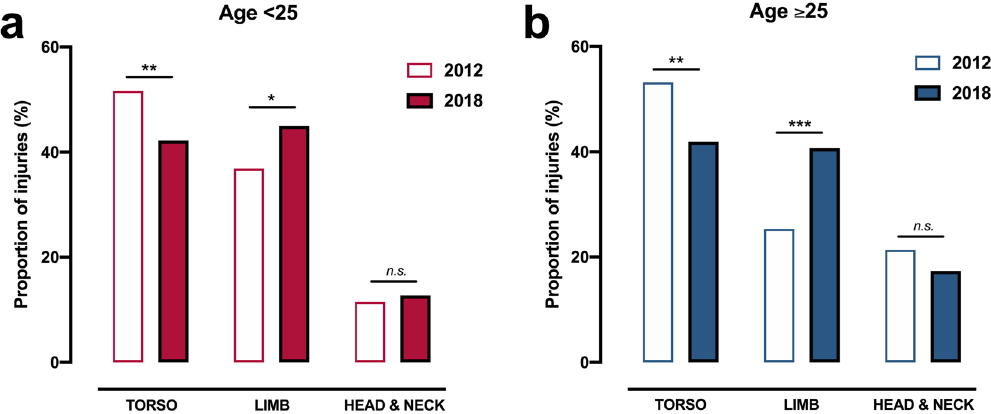
Figure 3. Changes in injury characteristics over time. ( A ) Young people (age < 25). ( B ) Older people (age ≥ 25). * p < 0.05; ** p < 0.01; *** p < 0.001, n.s. not significant, Fisher’s exact